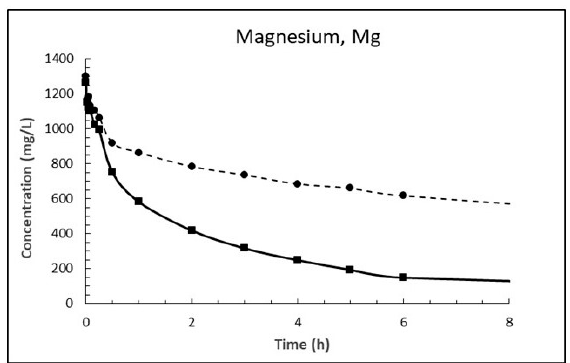
Figure 7. Concentration of magnesium in sea water at T = 5 °C (dashed line) and 15 °C (solid line) as function of time after adding 1% ( w / v ) fine CaO.